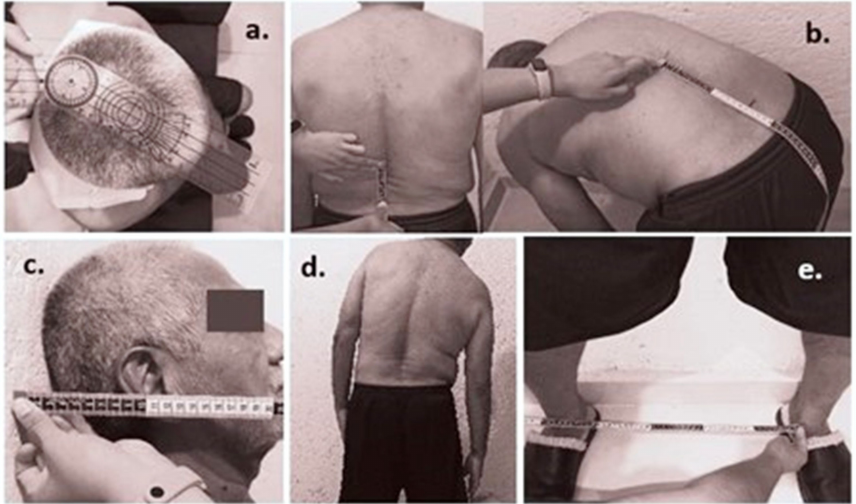
Figure 1. BASMI measurements: ( a ) cervical rotation (observed from a view perspective above of the subject head); ( b ) modified Schober test; ( c ) tragus-to-wall distance; ( d ) lumbar side flexion; ( e ) intermalleolar